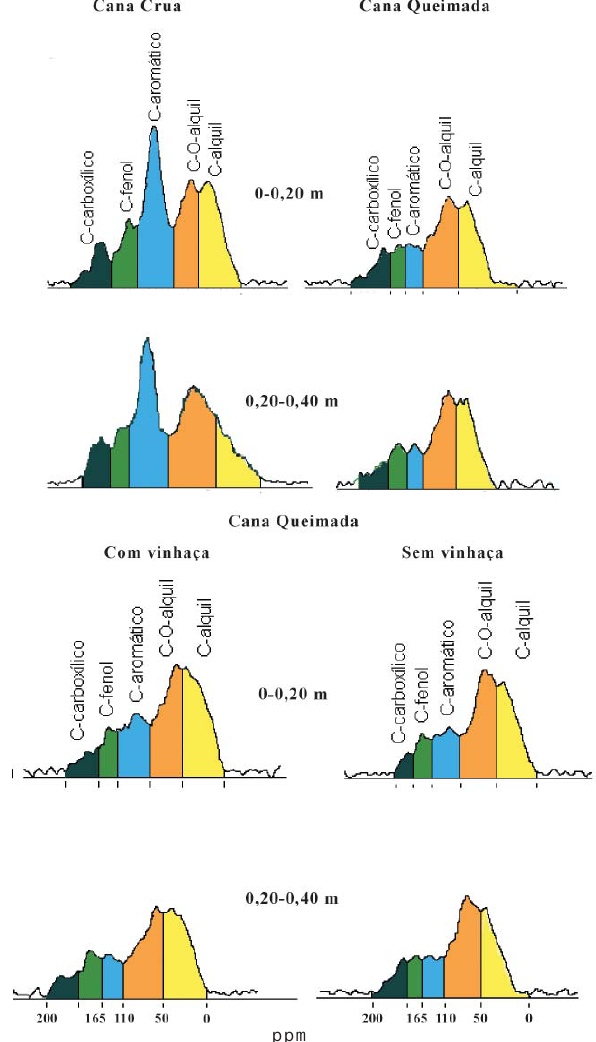
Figura 1. Espectros de RMN 13 C CP-MAS de amos- tras intactas de um Cambissolo Háplico